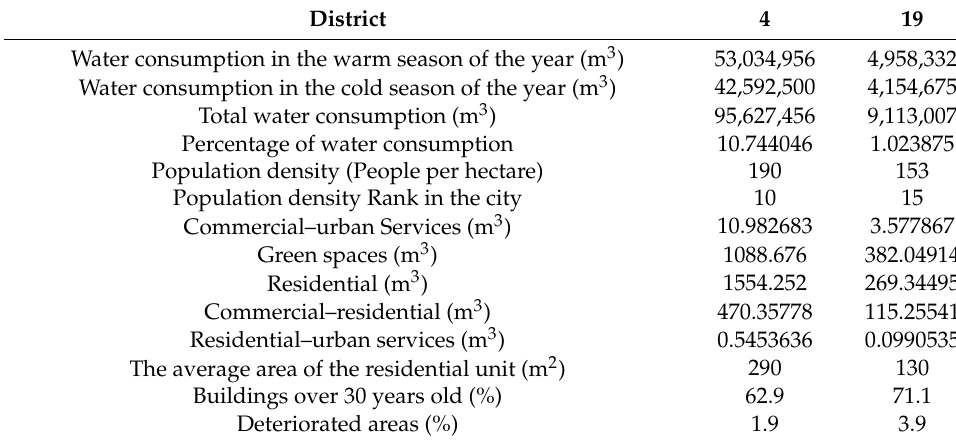
Table 9. Amount and percentage of water consumption in the districts of